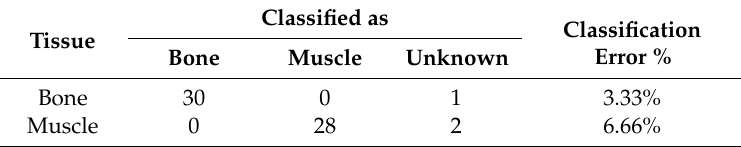
Figure 7. Acoustic shock wave di ff erentiation measured by an FBG during laser ablation at 7 J in wet conditions (Set 5): ( a ) Back reflected light in the time domain, ( b ) Spectrum of the back-reflected light, ( c ) Ellipsoids based on 20 scores from training data, ( d ) Classification of 30 scores from the test data in each ellipsoid of the training data. Table 2. Confusion matrix for the bone and muscle classification during the laser ablation at 7 J pulse